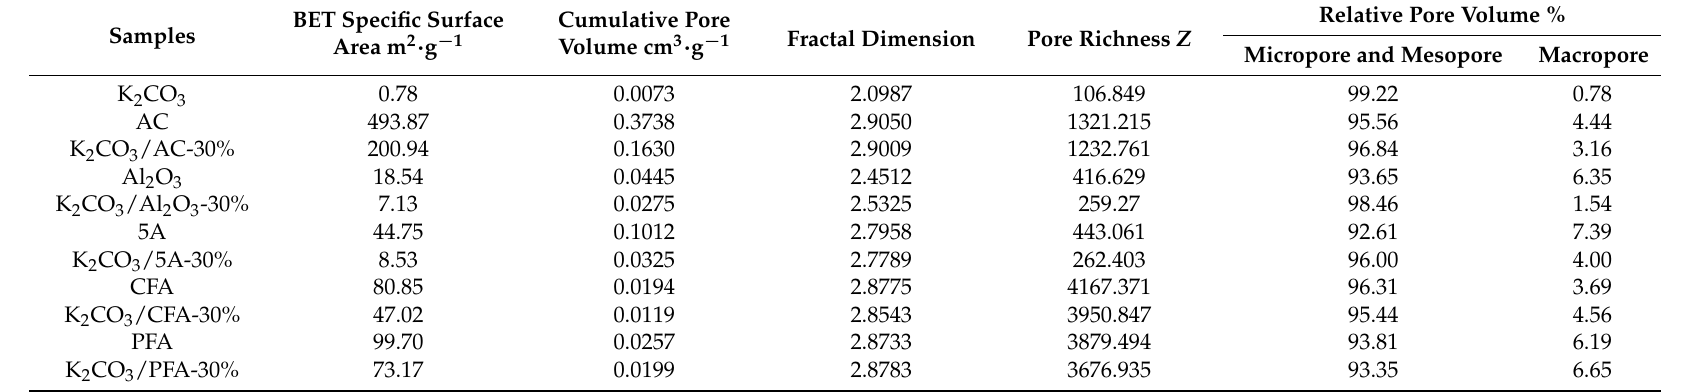
Table 3. Pore structure parameters of adsorbents before and after loading with the optimal theoretical